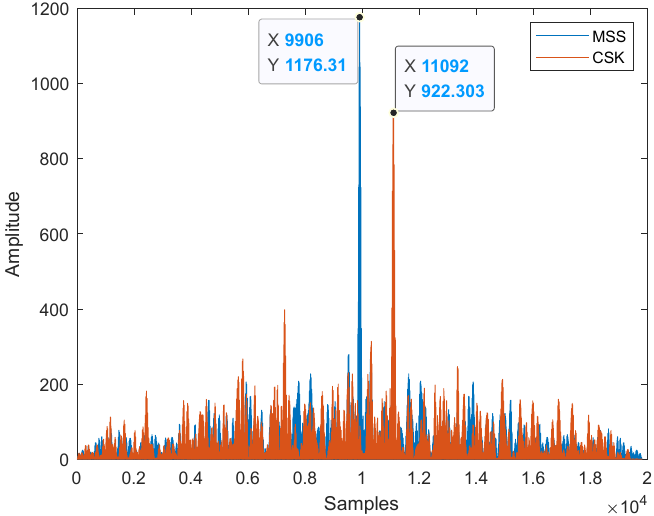
Figure 3. Correlation characteristics of MSS and CSK.